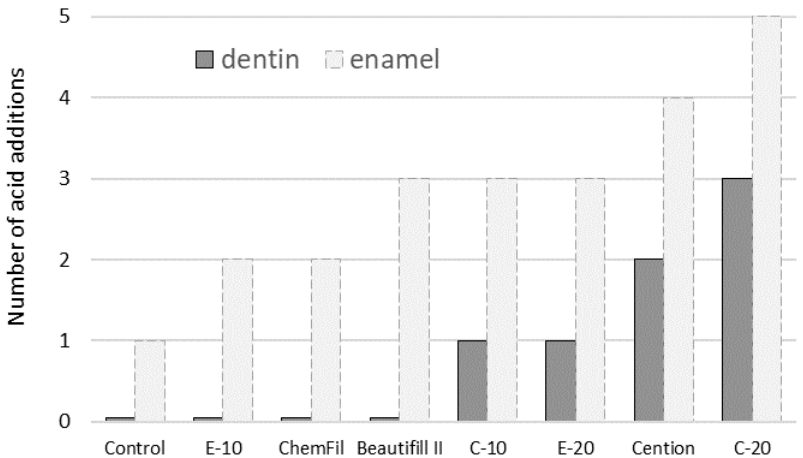
Figure 2. Number of acid addition cycles for which dentin surface MH remained statistically similar to initial values. Light-grey bars with dashed borders show the corresponding values measured in a previous study [19] for enamel blocks under the same experimental conditions.